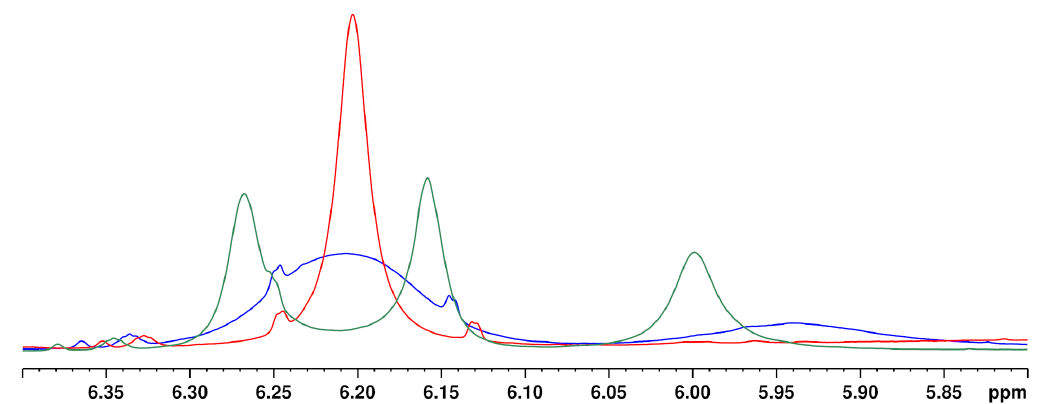
Figure 5. 1 H NMR spectra of a CBD + ∆ 9 -THC standard in hemp seed oil in the aromatic proton region at 280 K (green), 300 K (blue) and 320 K (red). Solvent: CDCl 3 .